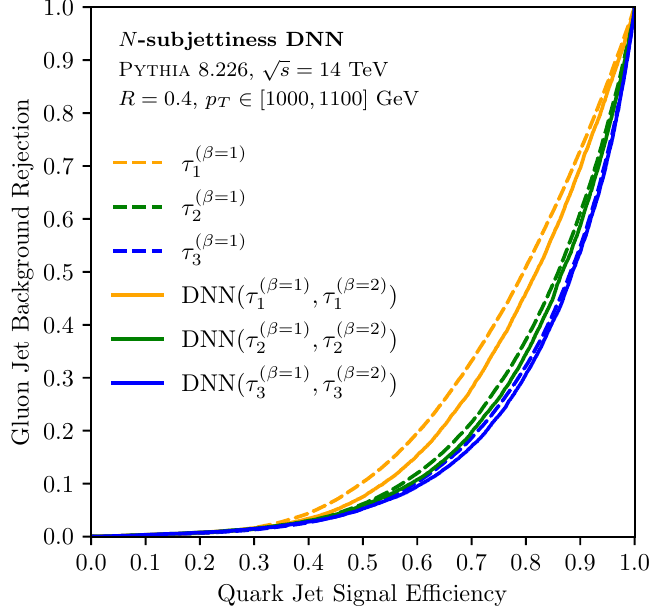
Figure 13. A comparison of the classi(cid:12)cation performance added by considering two N -subjettiness observables of the same N and di(cid:11)erent (cid:12) values. Combining (cid:12) = 1 and (cid:12) = 2 N -subjettiness observables with a DNN can increases the classi(cid:12)cation performance, particularly for N = 1. How- ever, the parametric discrimination power, namely the ROC curve near the endpoints, is largely unchanged and approaches that for the (cid:12) = 1 N